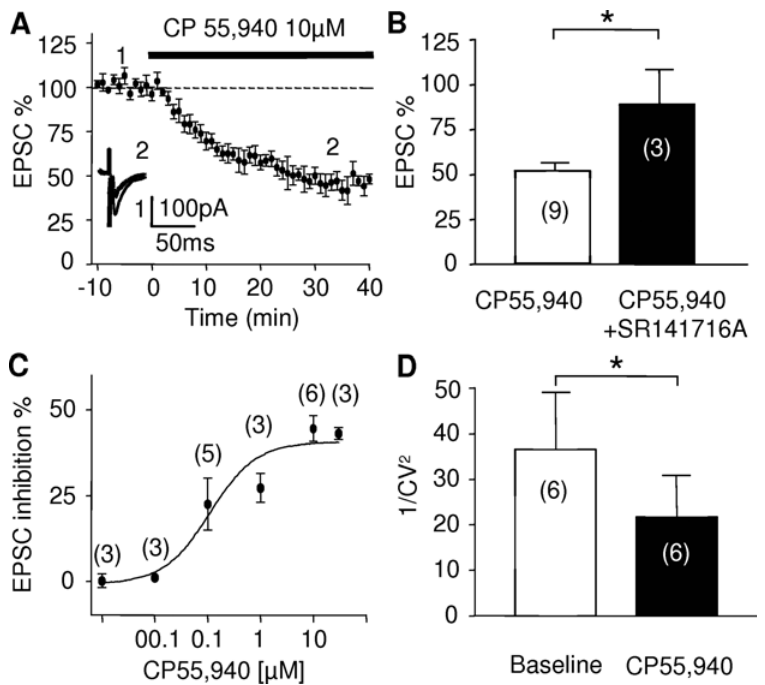
Figure 3. Pharmacological characterization of presynaptic CB1R at layer V-VI synapses of the PrPFC. Layer V-VI pyramidal cells were voltage- clamped and held at -70mV. (A) CB1R-mediated inhibition of evoked transmission. The cannabimimetic CP55,940 (10 m M) reduced evoked EPSCs on average to 48 6 5 % (n=6) of basal value. Traces represent the average of 10 consecutive EPSCs taken at the times indicated on the time-course graph. (B) The inhibitory effects of CP55,940 on evoked EPSCs were blocked by pre-treatment with the selective CB1R antagonist SR141716A (10 m M, t-test p=0.0386) in agreement with the involvement of CB1R. (C) Dose response curve measured 20 min after beginning CP55,940 application. Each point is expressed as the percentage of inhibition of its basal value. The EC50 was 195 6 0.3 nM. (D) The coefficient of variation, expressed as 1/CV